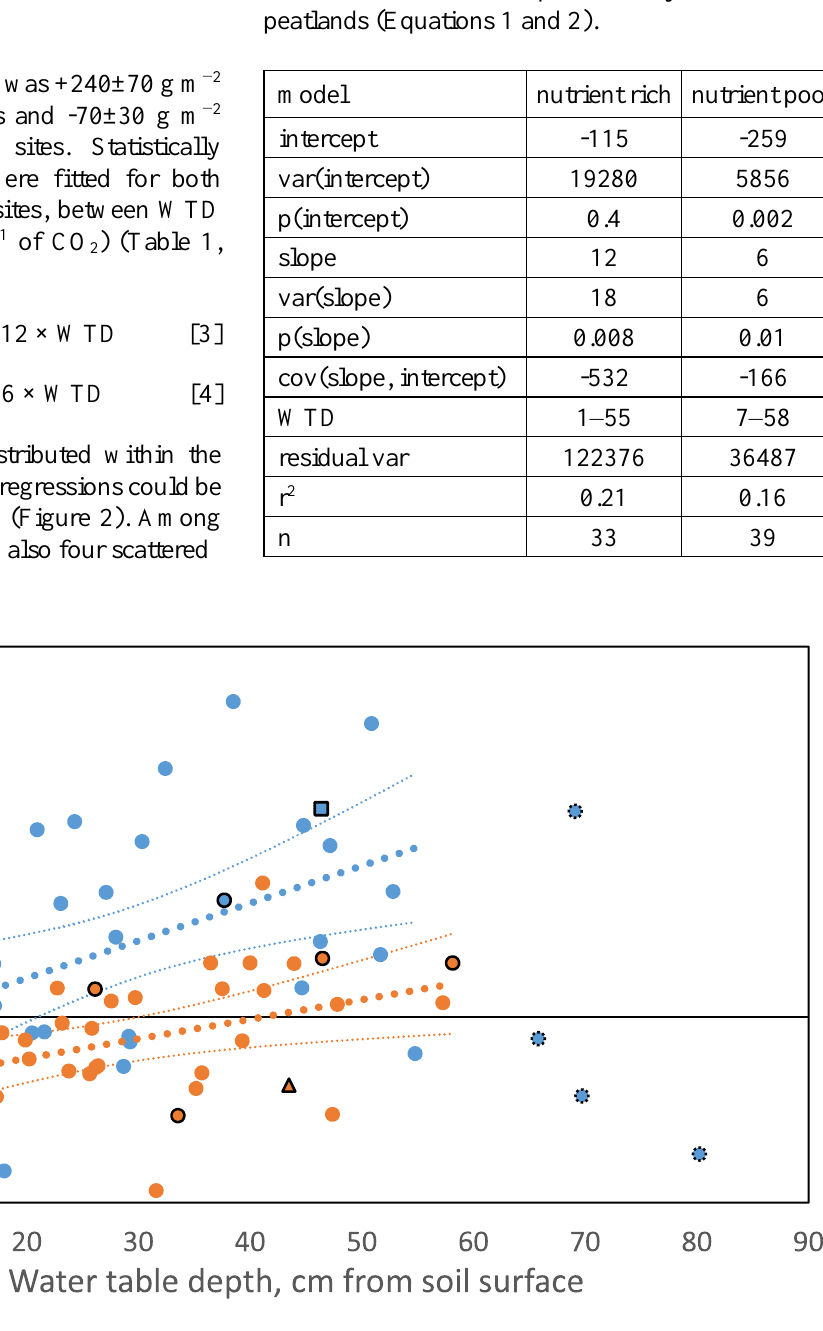
Table 1. Parameters (intercept, slope), their variances (var), significances (p) and covariance (cov) and water table depth range (WTD), residual variance, coefficient of determination (r 2 ) and number of observations (n) for the linear regressions between mean May–October water table depth (cm from soil